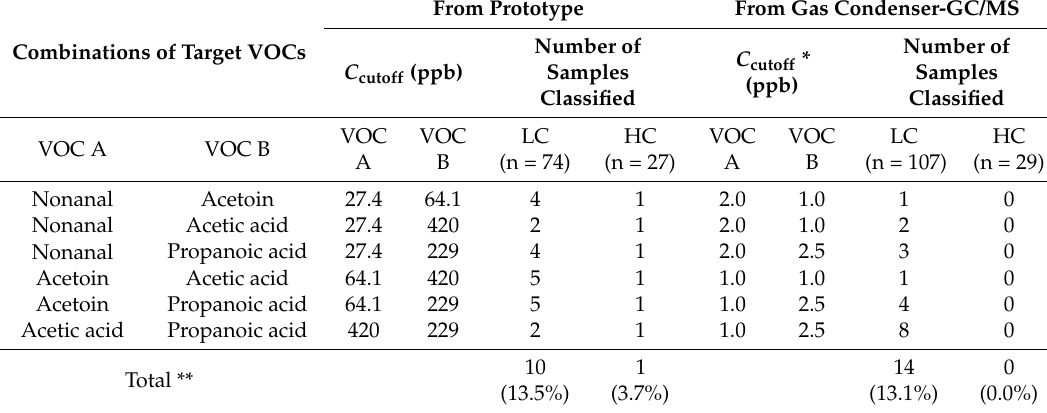
Table 4. Results of the simulation for detection of lung cancer from prototype analysis and gas condenser-GC/MS analysis using four target VOCs. The sample was classified as lung cancer when both VOCs were included with concentrations over the cutoff VOC